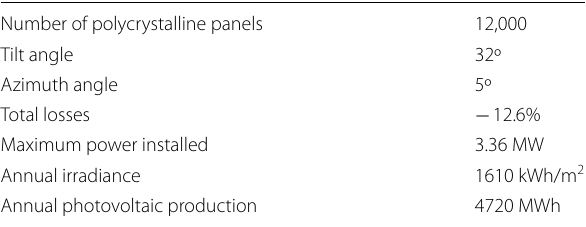
Table 7 Graciosa system design data with polycrystalline photovoltaic panels